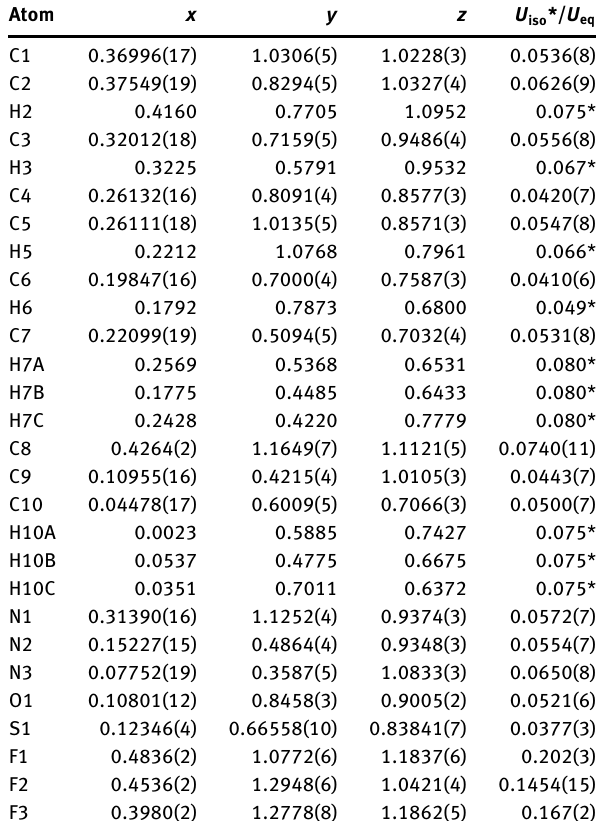
Table 2: Fractional atomic coordinates and isotropic or